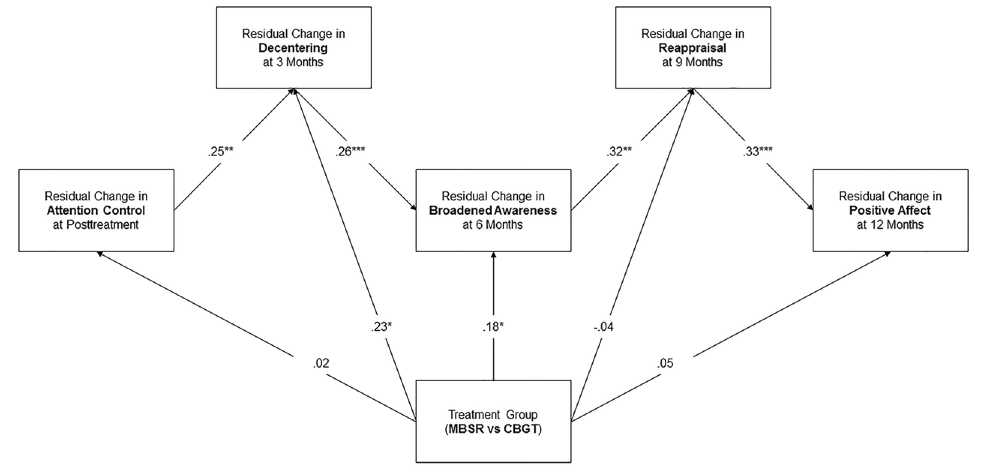
Fig 1. Final multivariate path model of the mindfulness-to-meaning theory. Note: Changewas computed in residualized change scores (follow-up levels adjustedfor pre-treatment levels). All paths are statistically significant.Model fit was excellent, χ 2 / df = 1.17, p = .22, CFI = .97, RMSEA = .04 (.00, .08).